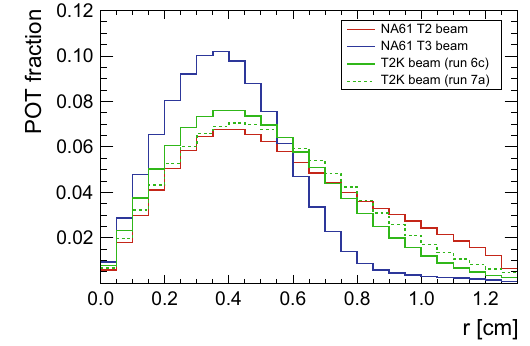
Fig. 3 Radial distributions of the incoming proton beam with respect to the center of the target: T 3 beam profile (blue), T 2 beam profile (red) and T2K beam profiles for two different runs (green). Beam profiles in T2Kchangeonarun-by-runbasisandperfectagreementisnotpossible. All distributions are normalised to the corresponding total number of protons on